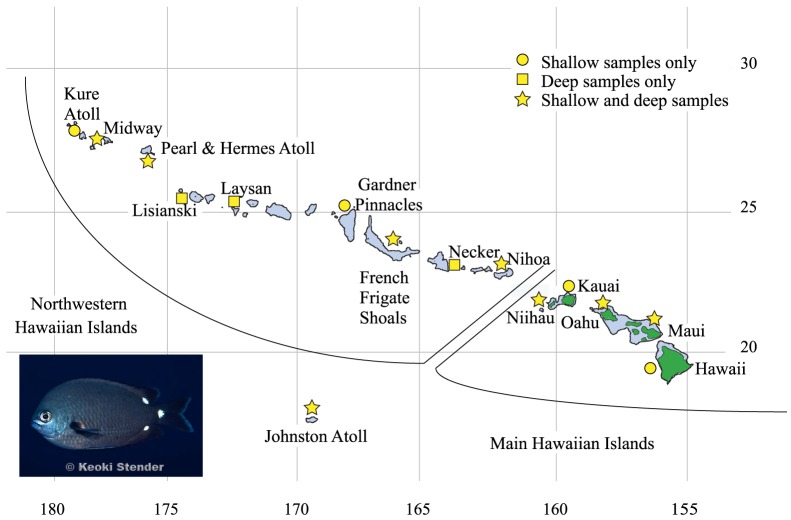
Map of collection locations.Collection locations for Chromis verater. Shapes indicate whether shallow (circle), mesophotic (square), or both shallow and mesophotic (star) specimens were collected at the location. (Photo credit: Keoki Stender, www.marinelifephotography.com).